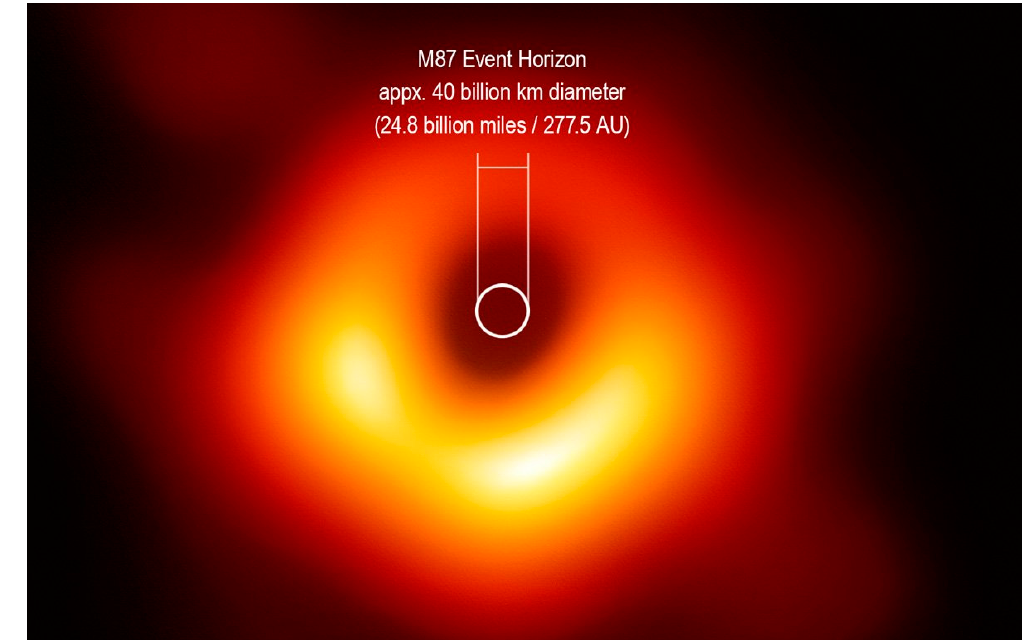
Figure 26. The shadow of the Black Hole at the center of the Galaxy M87. As shown, the even horizon is smaller than the resolution of the picture, so the detailed light paths in Figure 25 cannot be appreciated with the actual resolution of the Event Horizon Telescope. Figure taken from [165] and modified by